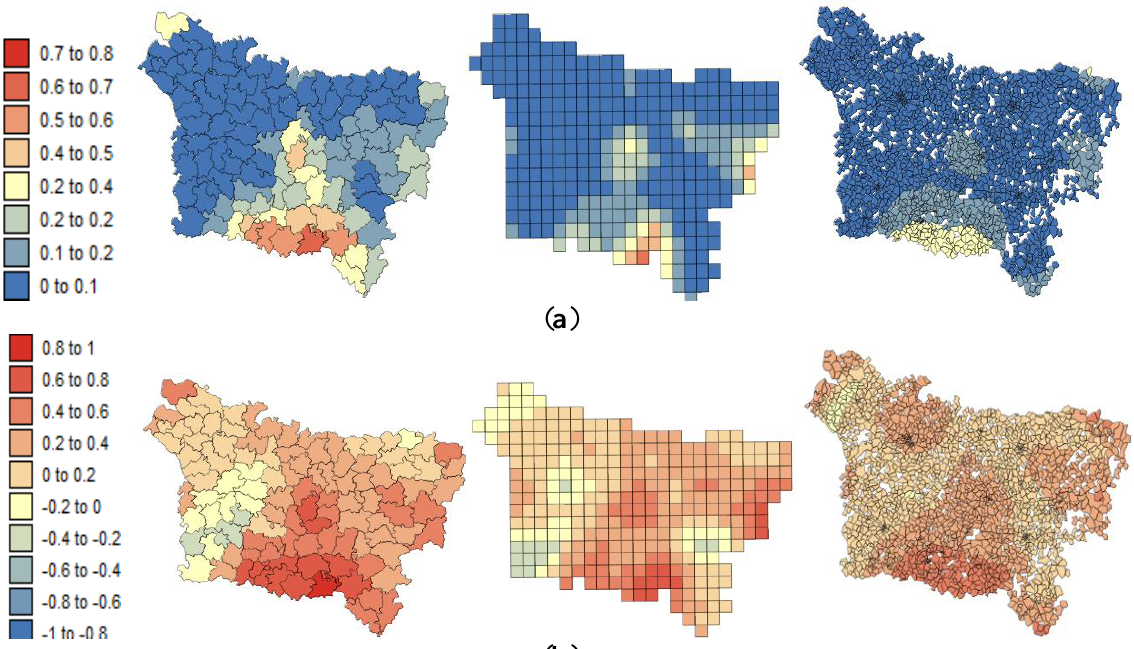
Figure 8. Results of the geographically weighted regression applied to the lip mortality kriged rates: ( a ) maps of the proportions of variance explained by deprivation index (R 2 ); ( b ) maps of the local correlation coefficients with the deprivation index